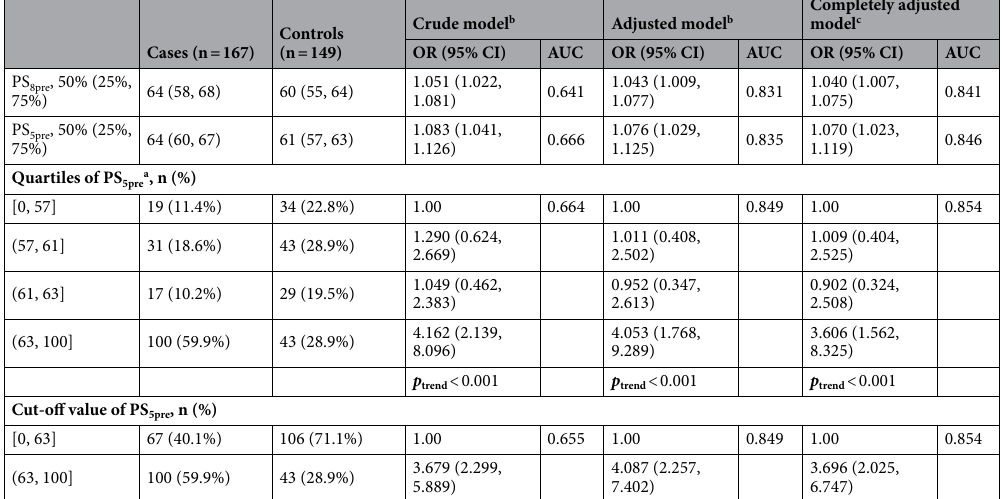
Table 2. The association between PS8pre or PS5pre and the risk of premenopausal breast cancer. a Defined by the quartile level in the control group. b Crude model: Only the score, without other environmental risk factors. Adjusted model: Adjusting age at menarche, residence, education, income, occupation, adverse pregnancy history, abortion history, energy intake and exercise. c Completely adjusted model: Adjusting WHR further. The sensitivity was 0.70, specificity was 0.52, positive predictive value was 0.62, negative predictive value was 0.61 and accuracy was 0.62 when only PS 5pre was included. According to the results of analysis, the number of proteins significantly different between groups was 5 of the premenopausal subjects, so the two scores were recorded as PS 8pre and PS 5pre